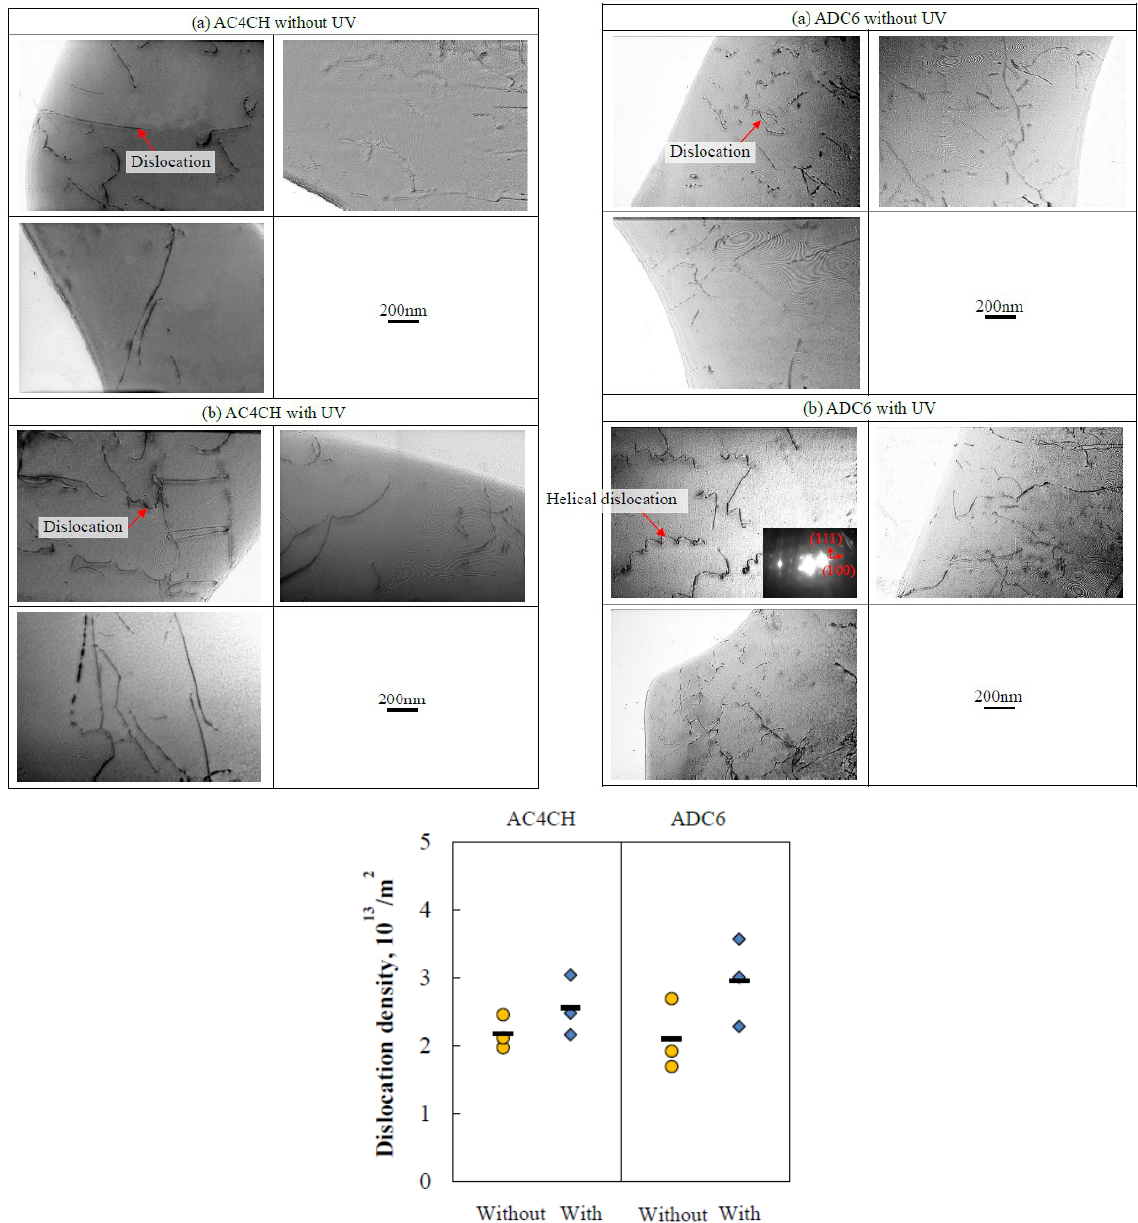
Figure 4. Transmission electron microscope (TEM) images of the AC4CH and ADC6 samples with and without ultrasonic vibration